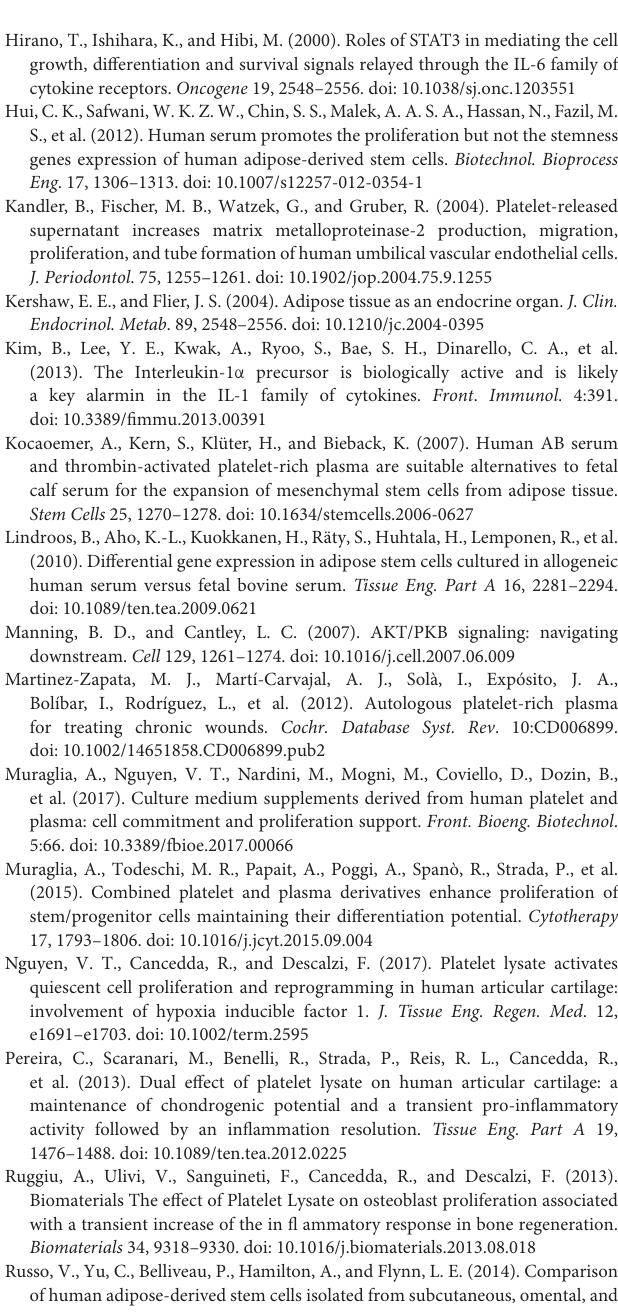
Supplementary Figure 1 | Chondrogenic differentiation of HS-expanded hASC at passage 2 by pellet-culture method. (A,B) Representative toluidine blue staining (A) and immunohistochemistry for collagen type II (B) of paraffin-embedded pellet cross sections (scale bars = 200 µ m). The images on the right are magnifications of highlighted